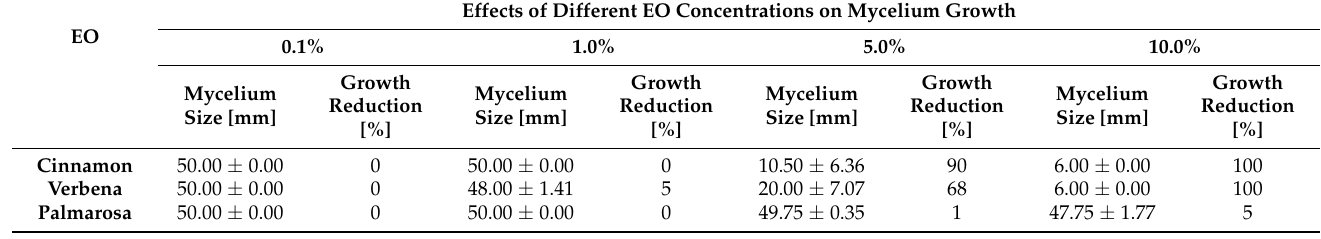
Table 1. Volatile effect of EOs on the mycelial growth of F. graminearum .